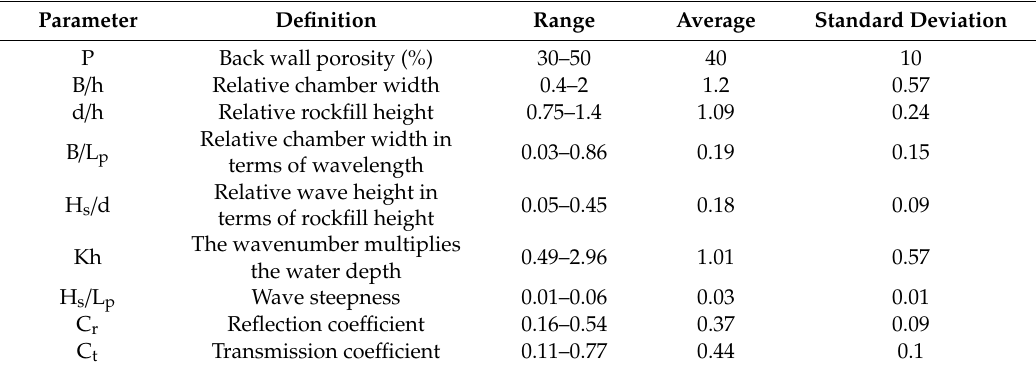
Table 2. Definitions and ranges of scaled model